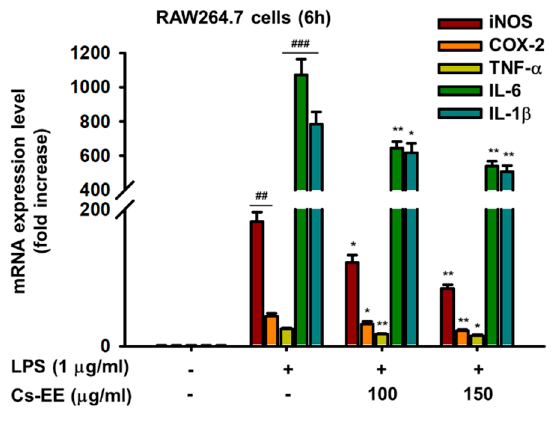
Figure 2. The phytochemical constituents of Cs-EE. ( a ) LC/MS-MS chromatogram of Cs-EE. ( b ) Chemical structure of the well-known flavonoids that was identified in Cs-EE. ( c and d ) Supernatant NO levels in RAW264.7 cell cultures pre-treated with indicated concentrations of ingredient compounds (kaempferol, genistin, and apigenin) in the presence or absence of LPS (1 μ g/mL), were determined using the Griess assay. Results (b and c) are expressed as mean ± SD. #### p < 0.0001 compared to normal group (no treatment), *** p < 0.001 and **** p < 0.0001 compared to control group (LPS alone). A p- value was analyzed using the student’s t